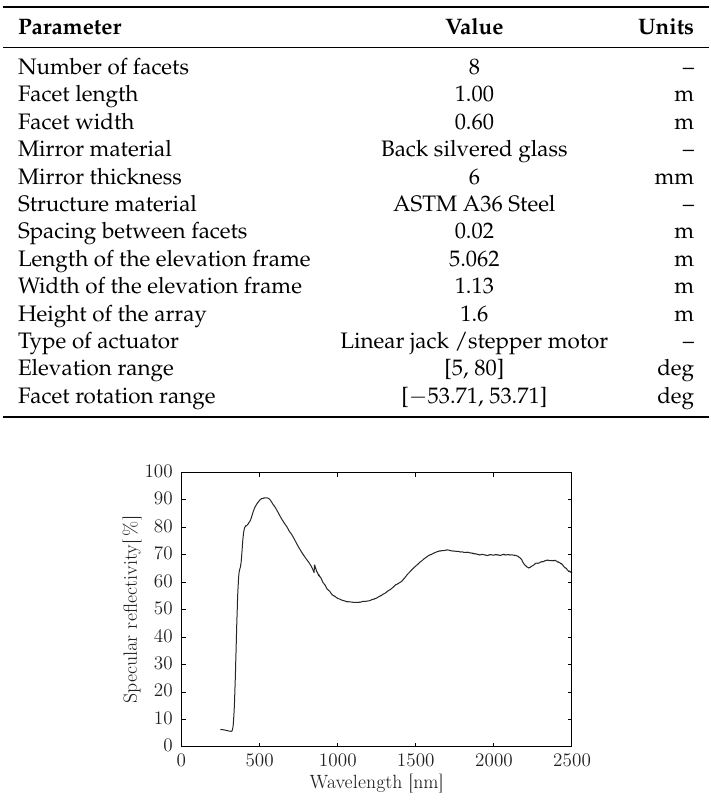
Figure 14. Specular reflectivity of the mirrors in the